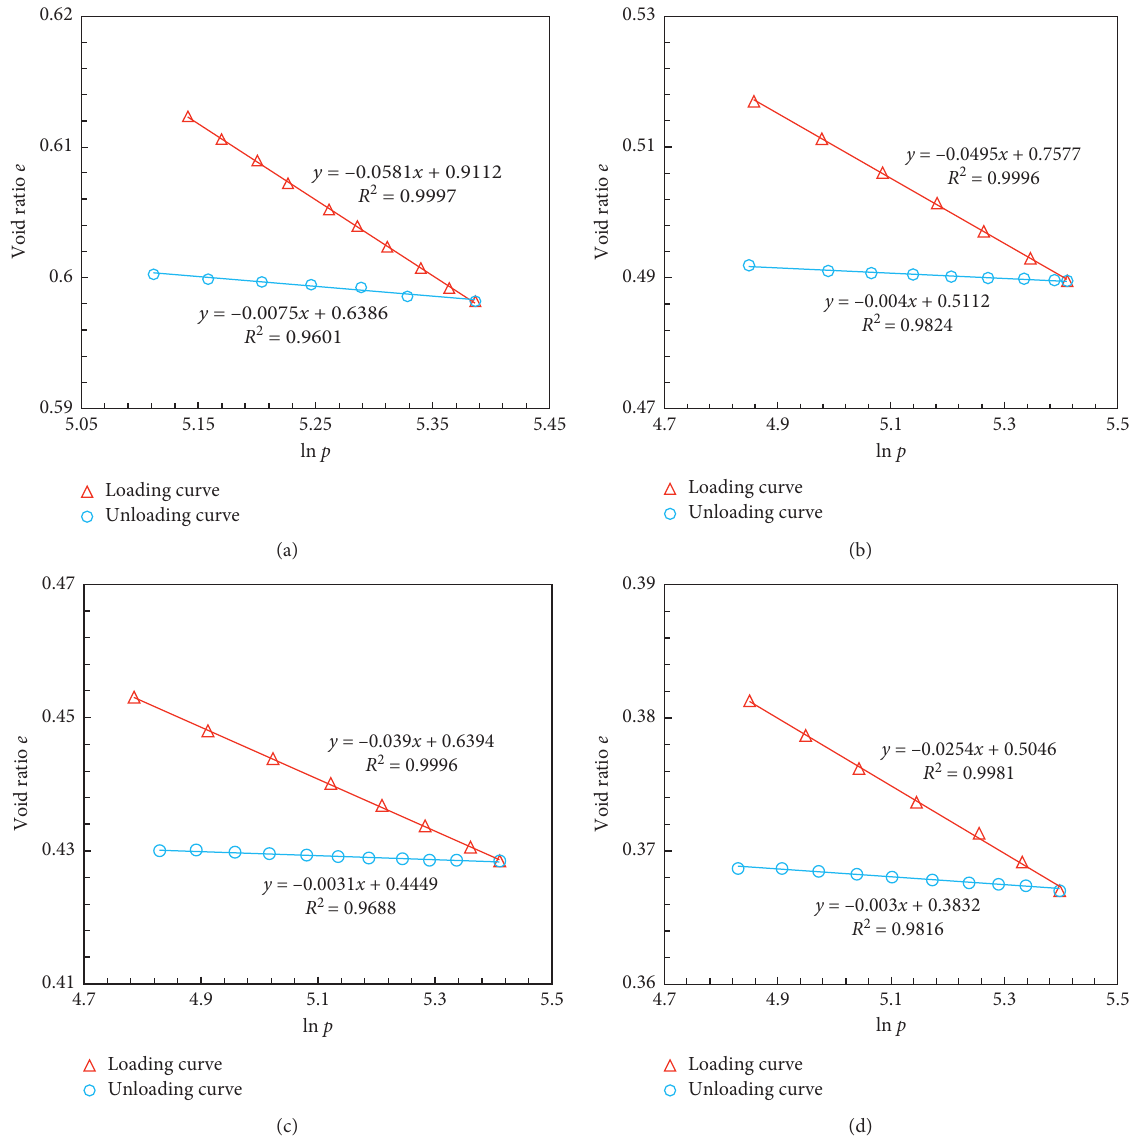
Figure 12: Compression coefficient λ and rebound coefficient k of gravelly sand for four different initial relative densities. (a) Gravelly sand D r � 0.15. (b) Gravelly sand D r � 0.35. (c) Gravelly sand D r � 0.55. (d) Gravelly sand D r �